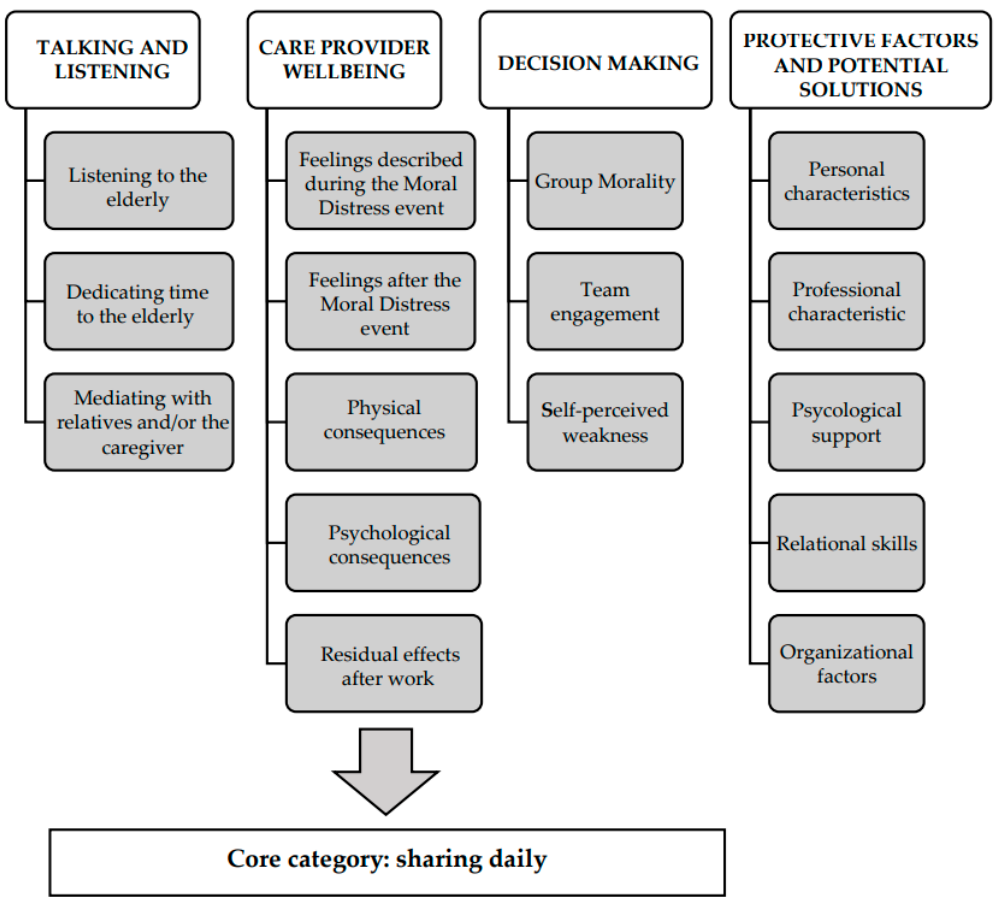
Figure 1. Category and sub-category.